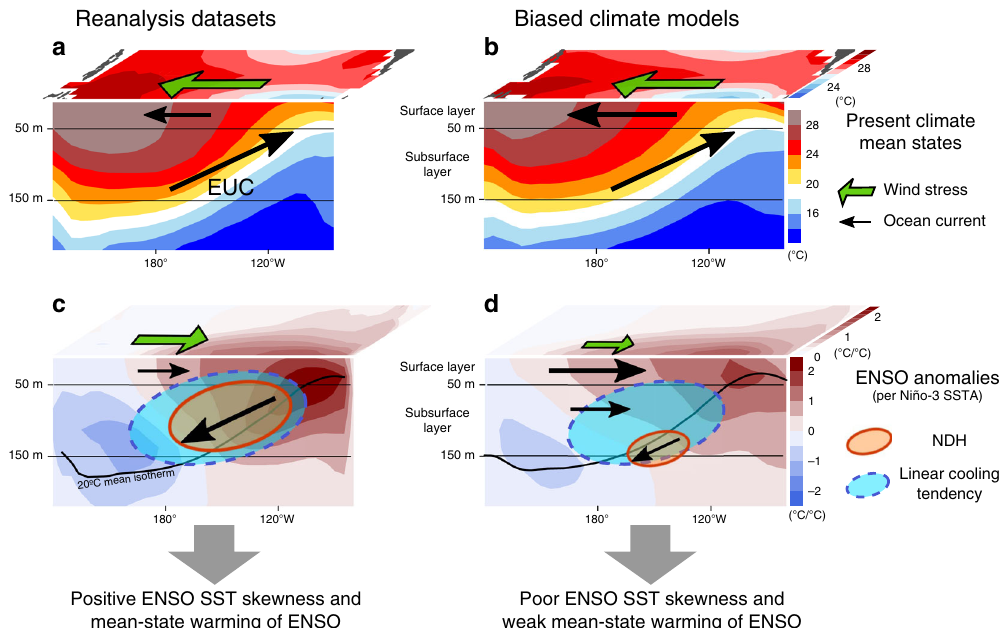
Fig. 4 Schematic of oceanic nonlinear dynamics for ENSO asymmetry. Shown are the climate mean states ( a , b ) and ENSO anomalies ( c , d ) for the sea surface temperature from the equator to 15°N and equatorial potential temperature derived from the multiple reanalysis datasets ( a , c ) and a subset of CMIP climate models (group L) having too-weak nonlinear dynamical heating (NDH) ef fi ciency ( b , d ). Green and black arrows represent the zonal wind stress and ocean currents along the equator. Solid orange and dashed cyan ovals indicate the NDH and linear dynamical (advective) cooling tendency, respectively, in the transition phase from El Niño to La Niña. See Supplementary Figs. 2 and 4 for the details of each